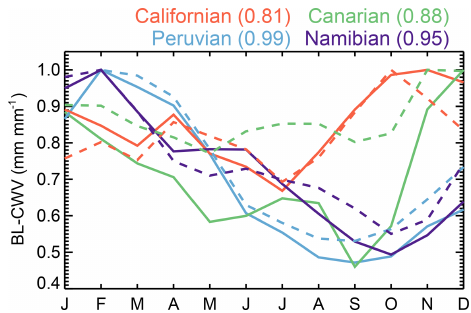
Figure 10. Normalized measured seasonal cycle of BL-CWV (solid lines), as well as derived from simple mixed-layer model (dash lines) for the regions delimited in Fig. 6 by the rectangular boxes. The numbers in brackets are the correlations coefficient between the measured BL-CWV and the modeled one.